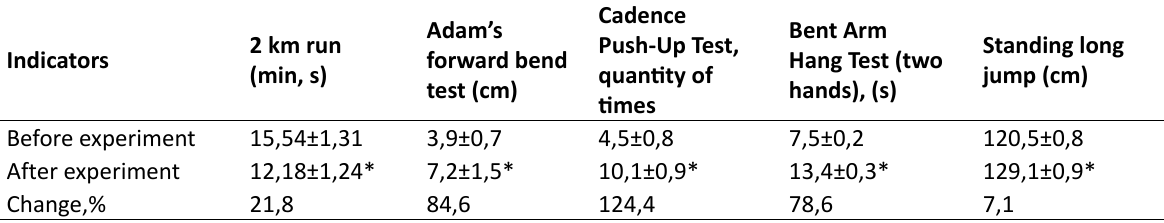
Table 5. Dynamics of indicators of physical fitness of women (±m)